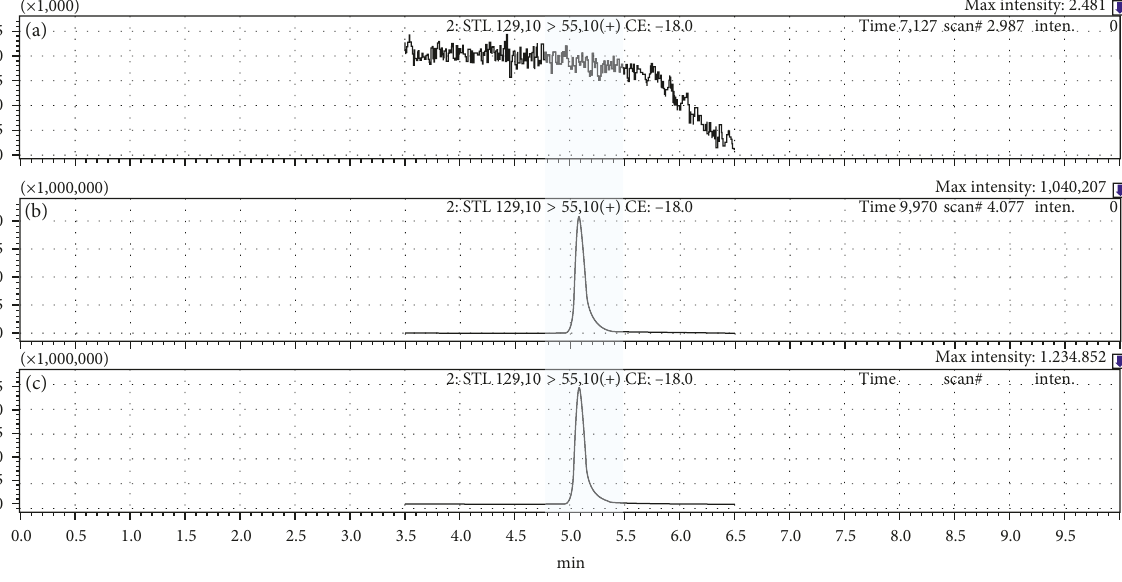
Figure 2: Typical chromatograms of synthetic wine (a), a standard calibration solution of 250 µ g/L (b), and a fortified wine (c) using the proposed single-step extraction procedure.